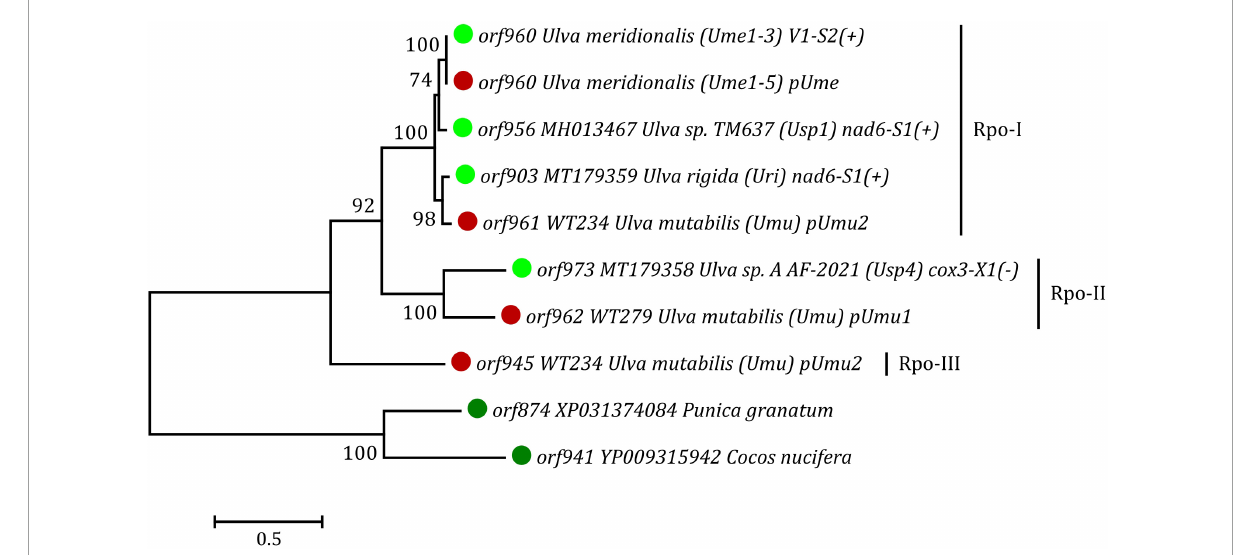
FIGURE6 Phylogenetic tree based on Maximum Likelihood (ML) analysis of amino acid (aa) sequences of the full length Rpo proteins found in Ulva mitogenomes and putative plasmids. The ML analysis was performed with 1,000 bootstrap replicates using MEGA 7.0. The bootstrap support values greater than 70% were displayed at branches. Branch lengths were proportional to the amount of sequence change, which were indicated by the scale bar below the trees. The tree was rooted with two Rpo proteins from Punica granatum (XP031374084) and Cocos nucifera (YP009315942),